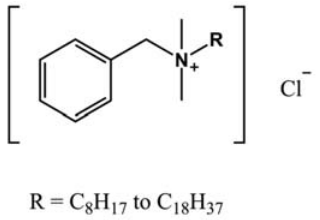
Figure 1. Structural formula of benzalkonium chloride.